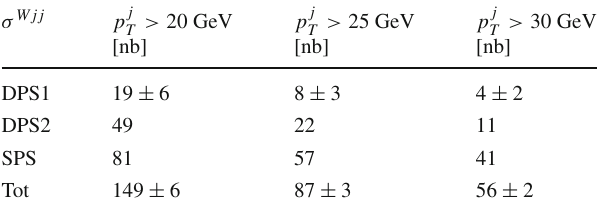
Table 1 Predictions for W jj DPS and SPS cross sections in pA col- lisions in fiducial phase space, for different cuts on jets transverse momenta. These numbers refer to charged summed W cross sections accounting for the W boson decaying into muons as well as